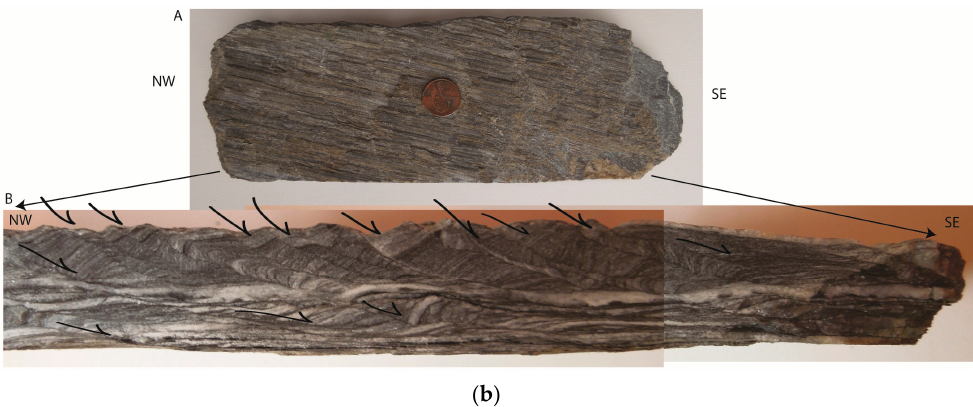
Figure 3. ( a ) Normal fault gouge zone with folded fault drag kinematics. Shear zone is grooved ( A ; top view) and, in cross-section, reveals normal faulted folds ( B ) shown in thin section ( C ; full section in plane light) with close-up of fault drag and calcite twins ( D ; plane light). Coin for scale (3.8 mm diameter); ( b ) top photo of striated, bedding-parallel normal fault zone with steps down-to-the-SE ( A ), and a cross-section of the same sample ( B ) showing normal fault offsets, listric to the local shear zone base. Geosciences 2016 , 6 , 10